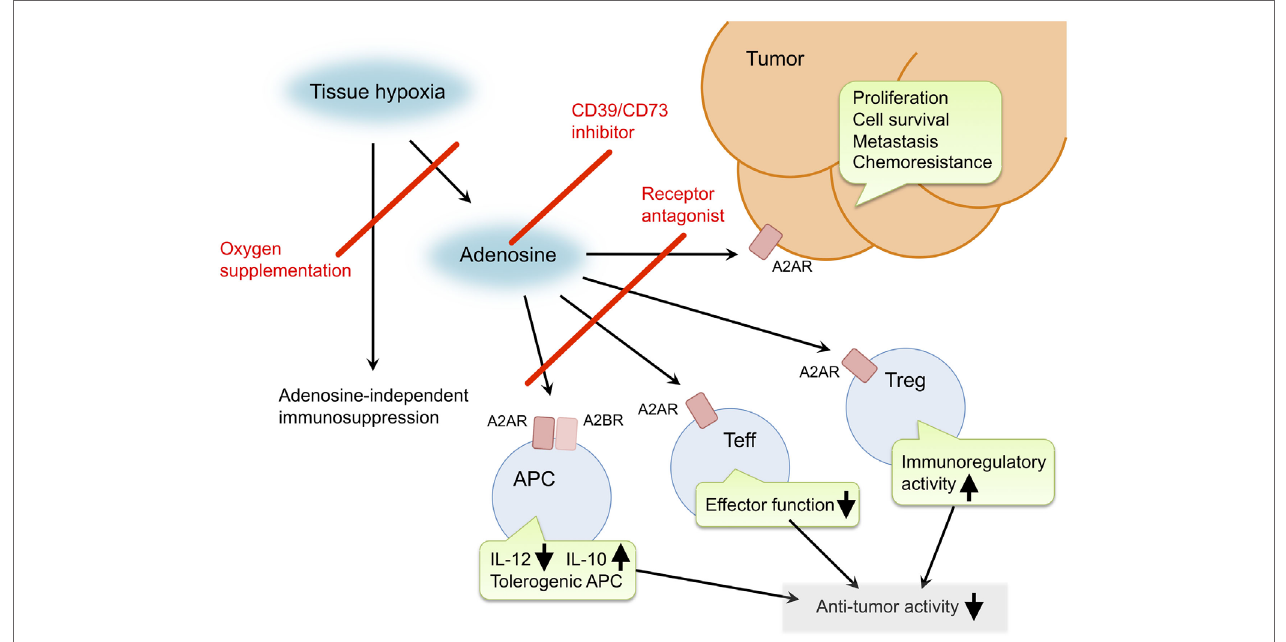
FiGURe 1 | Pro-cancer activities of extracellular adenosine and therapeutic targets for improvement of cancer immunotherapy . Tissue hypoxia in tumors increases extracellular adenosine production through induction of CD39 and CD73. Produced adenosine transmits immunosuppressive signals through adenosine receptors on various immune cells. A2AR stimulation in effector T cells (Teff) blocks T cell receptor signaling and impairs effector functions including IFN- γ production and cytotoxicity. In antigen-presenting cells (APC), signals through A2AR and A2BR reduce Th1-type cytokine milieu and induce tolerogenic APC. Interaction of Teff with these APC will impair activation of cellular immune response against cancer cells. Adenosine enhances immunoregulatory activity of regulatory T cells (Treg). The qualitative and quantitative increase of Treg results in stronger inactivation of antitumor immune response. In addition, adenosine can promote proliferation, survival and metastatic activity of cancer cells. Suppression of adenosine pathway will be able to weaken the intensity of immunosuppression in tumor microenvironment and direct effect on cancer cells. Potential target molecules are adenosine receptors (A2AR and A2BR) and adenosine-producing enzymes (CD39 and CD73). Oxygen supplementation can also decrease pro-cancer effects of adenosine as well as adenosine-independent immunosuppression by